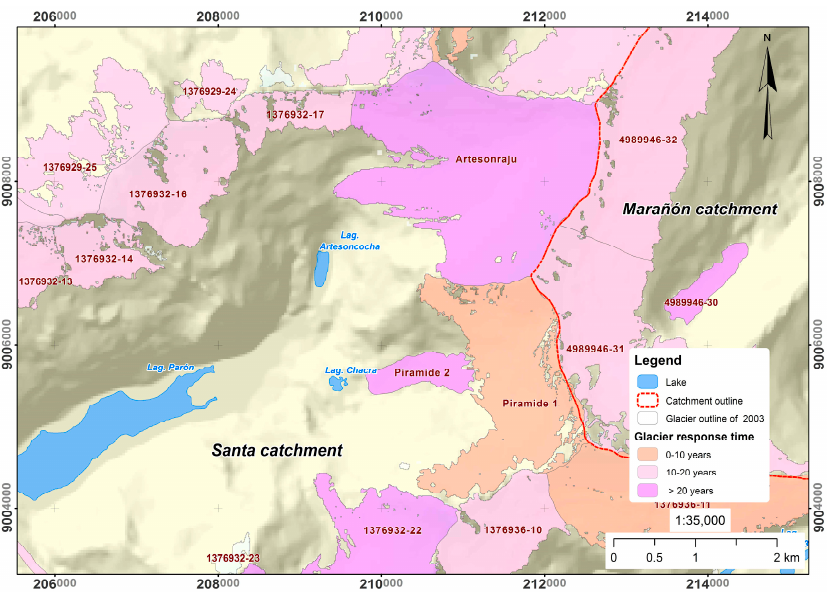
Figure 10. Calculated glacier response times in the catchment of the Laguna Parón. Piramide 2 (like 4989946-30 in the Marañon catchment) is a debris-covered glacier tongue essentially decoupled from the upper glacier parts. Calculated response times in such cases concern disintegrating and downwasting ice. They primarily indicate generally long but still unknown response times rather than specific values. Glacier outlines are from [15].